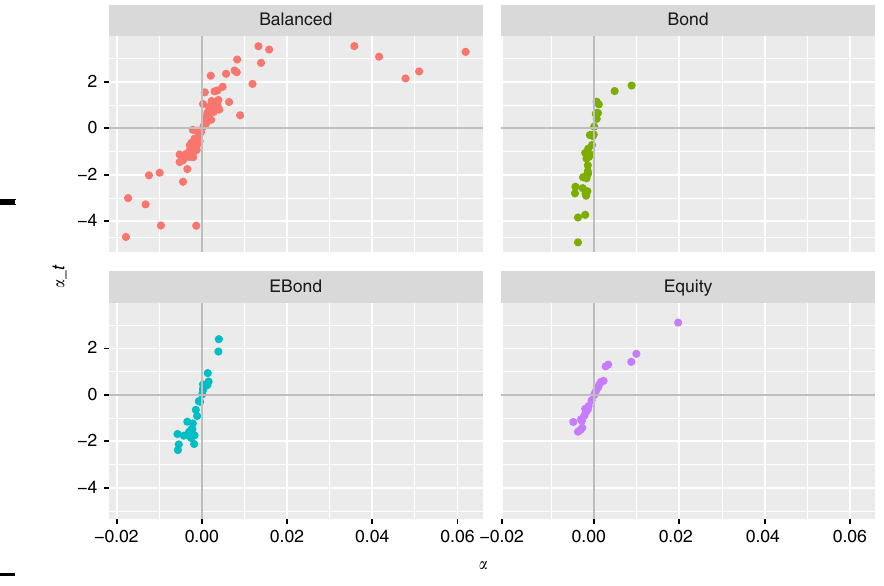
Figure 3. Factor regression α s